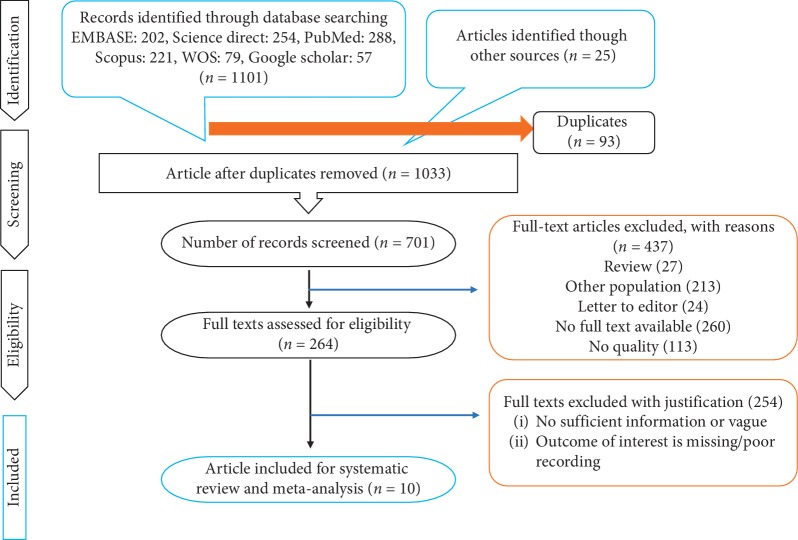
PRISMA flow diagram.